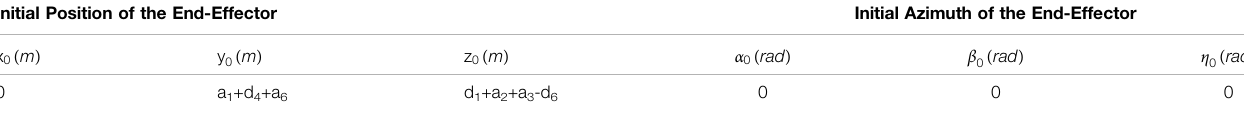
TABLE 2 | Initial position of the end-effector of the robot arm and the orientation